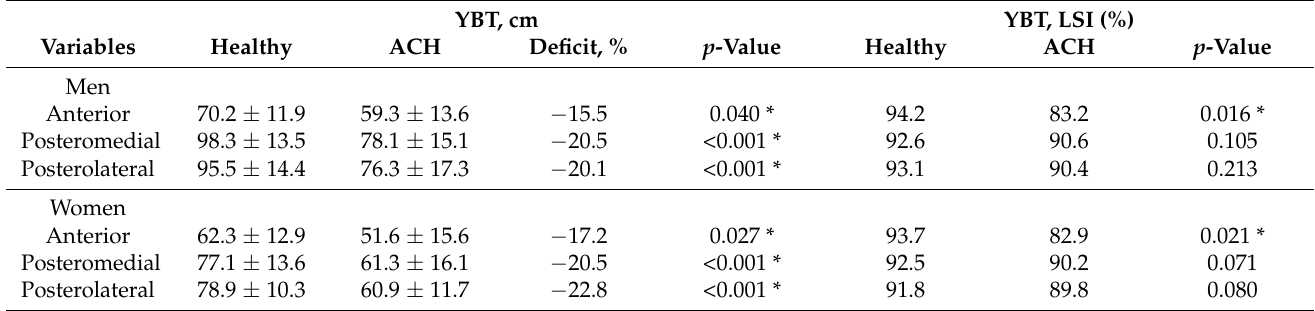
Table 4. Dynamic balance of healthy controls and patients with